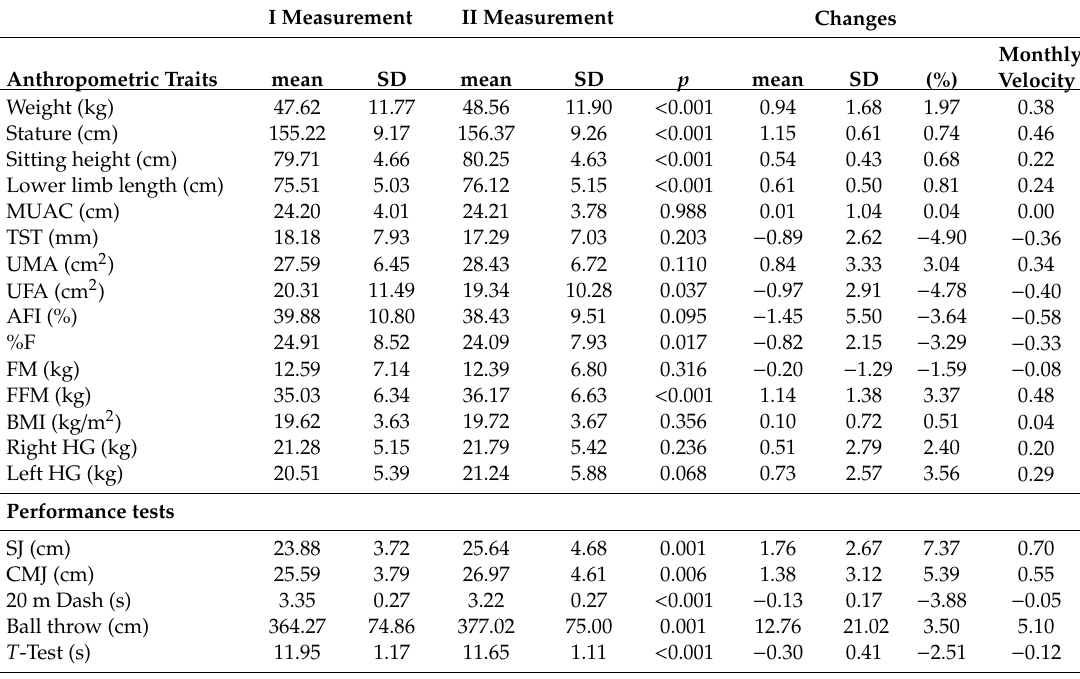
Table 1. Descriptive statistics (mean and SD), changes between two measurements, and monthly velocity of anthropometric traits and performance tests. I Measurement II